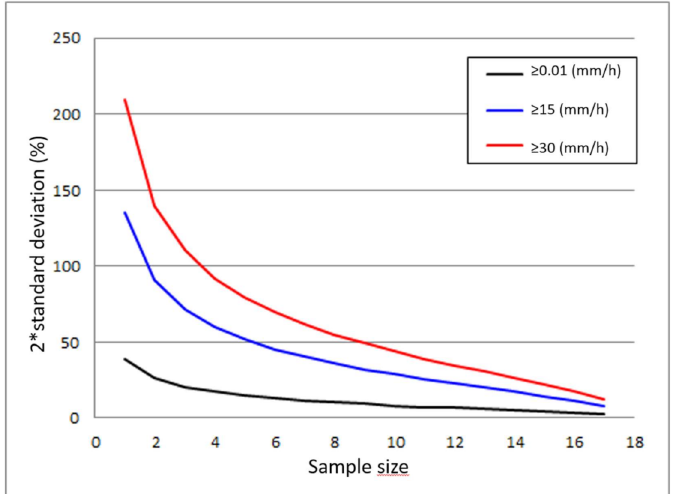
Figure 11. The length of time series (sample size) and +2 standard deviations for three rain rates for wind speeds ≥ 7 m s − 1 based on 18 years of rain rate observations at Hvide Sande